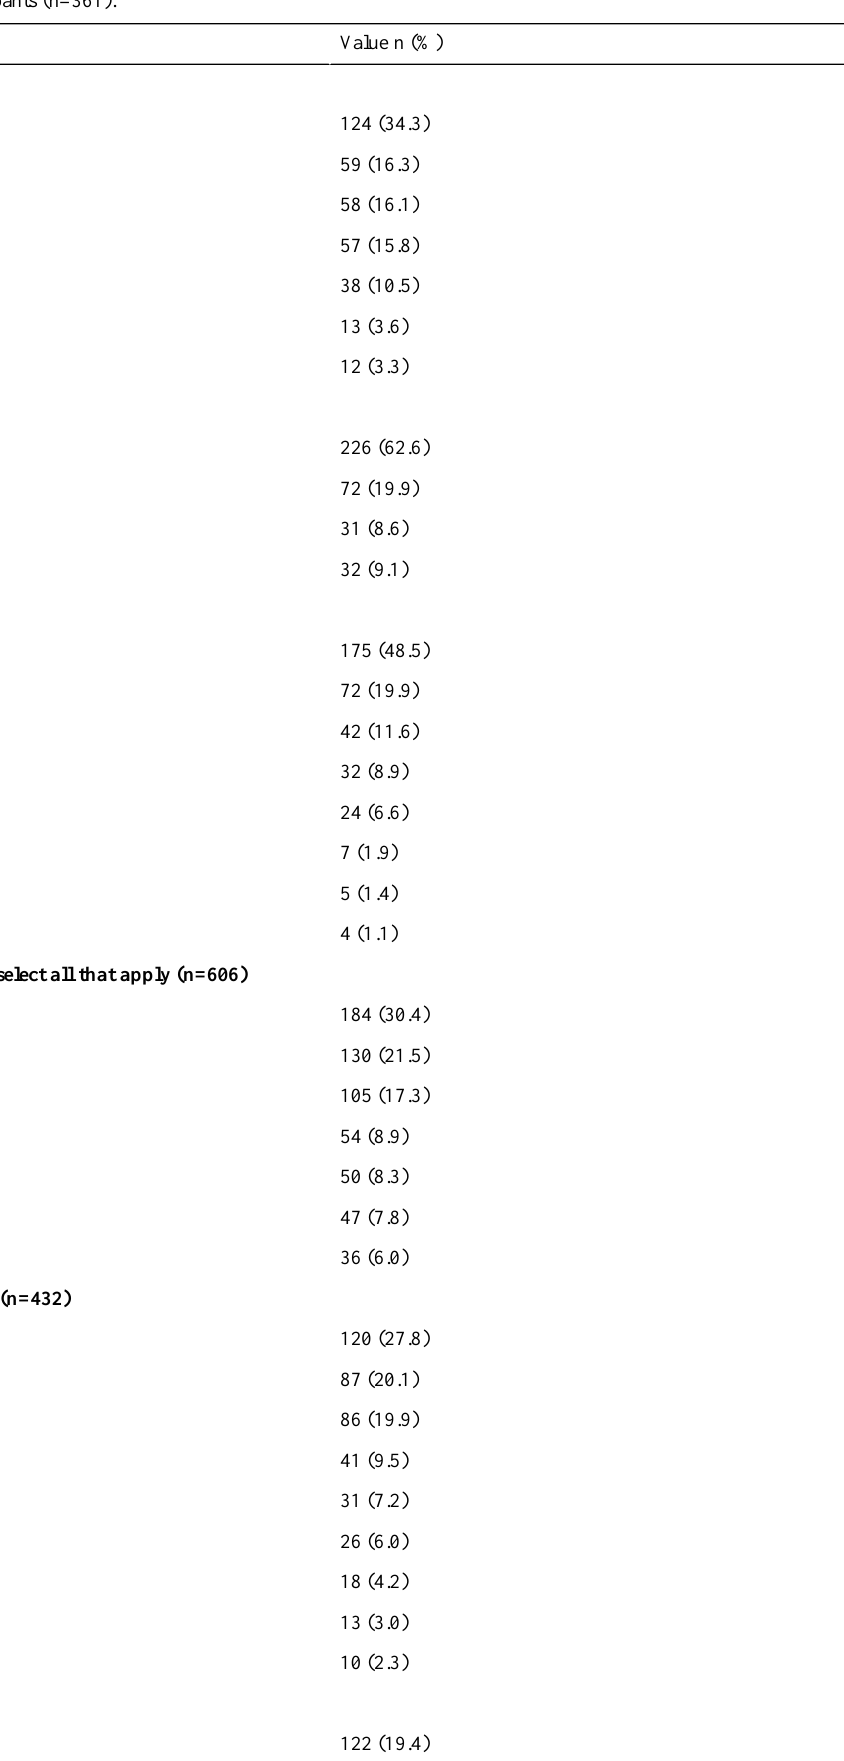
Table 2. Wound care experience of participants